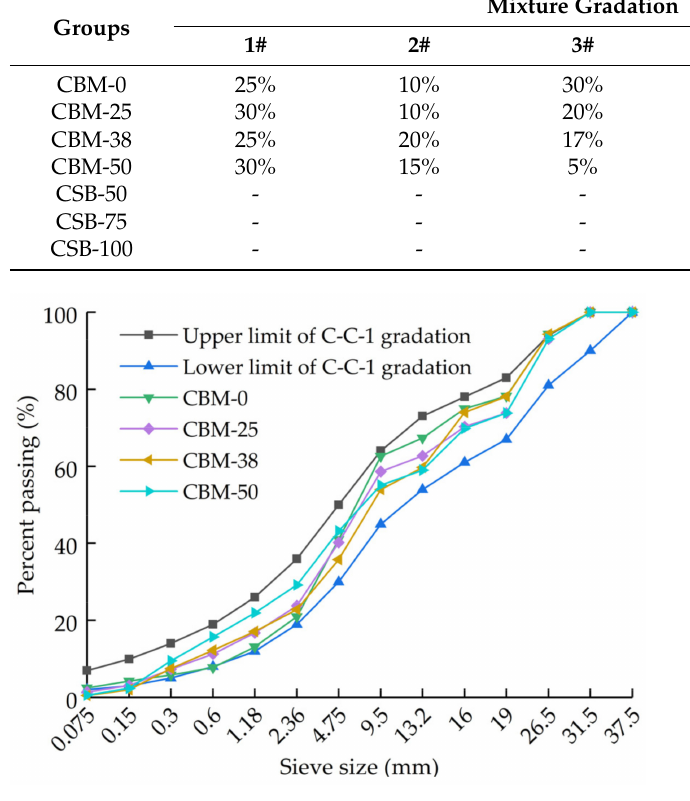
Figure 3. Gradation curve of